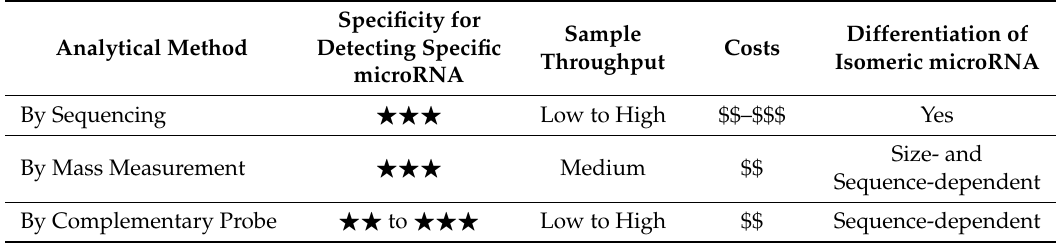
Table 3. Current categories of analytical methods for measuring